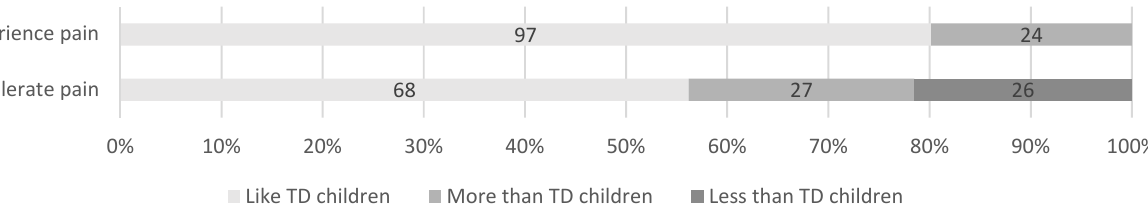
Figure 1. Paediatricians’ ( n = 121) views on the pain experience of children with profound intellectual and multiple disabilities (PIMD) compared with typically developing (TD) children.